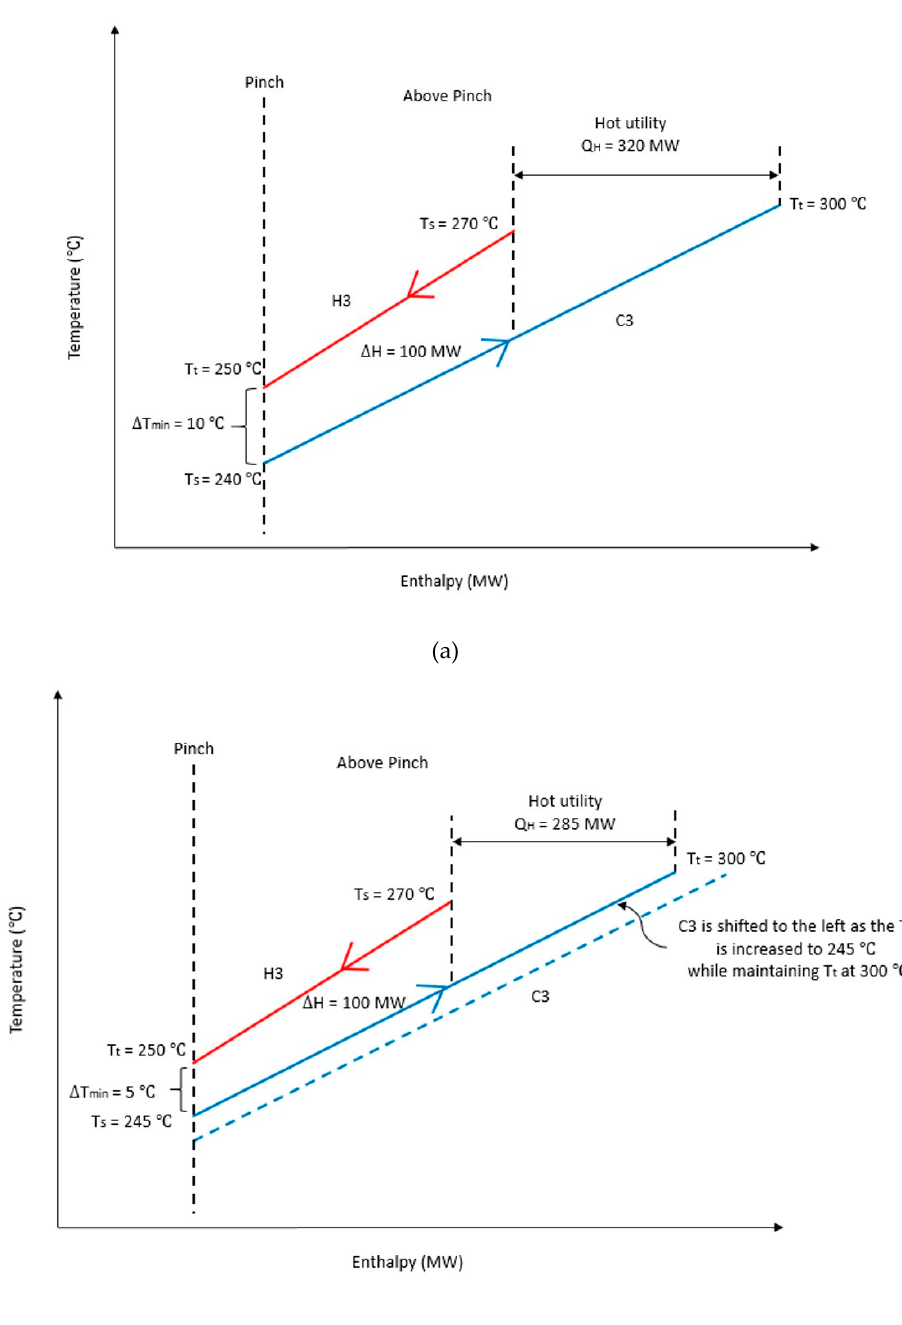
Figure 13. ( a ) The plus-minus principle of nominal T S for cold stream at the pinch with T min = 10 ℃ ; ( b ) The plus-minus principle of infeasible matching with increasing T S for the cold stream at the pinch. Observation 7. Decreasing T S for a hot or cold stream above the pinch results in increasing Q H .